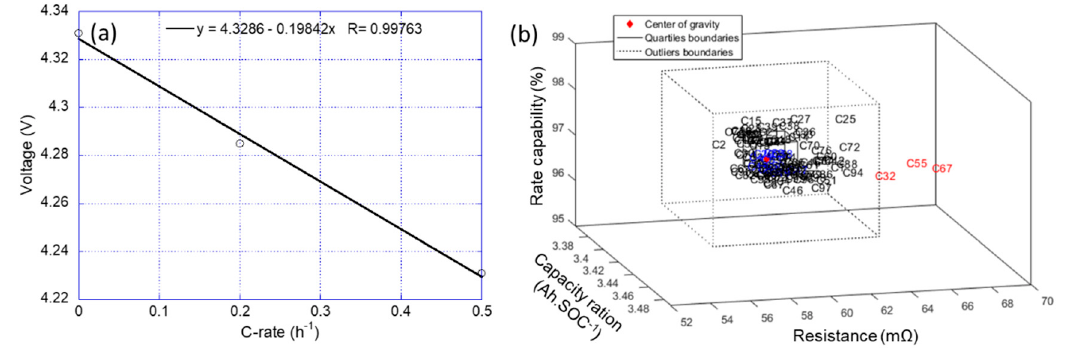
Figure 4. ( a ) Initial voltage vs. rate for the resistance calculation and ( b ) cell-to-cell variation representation in a 3D space adapted from [29] .